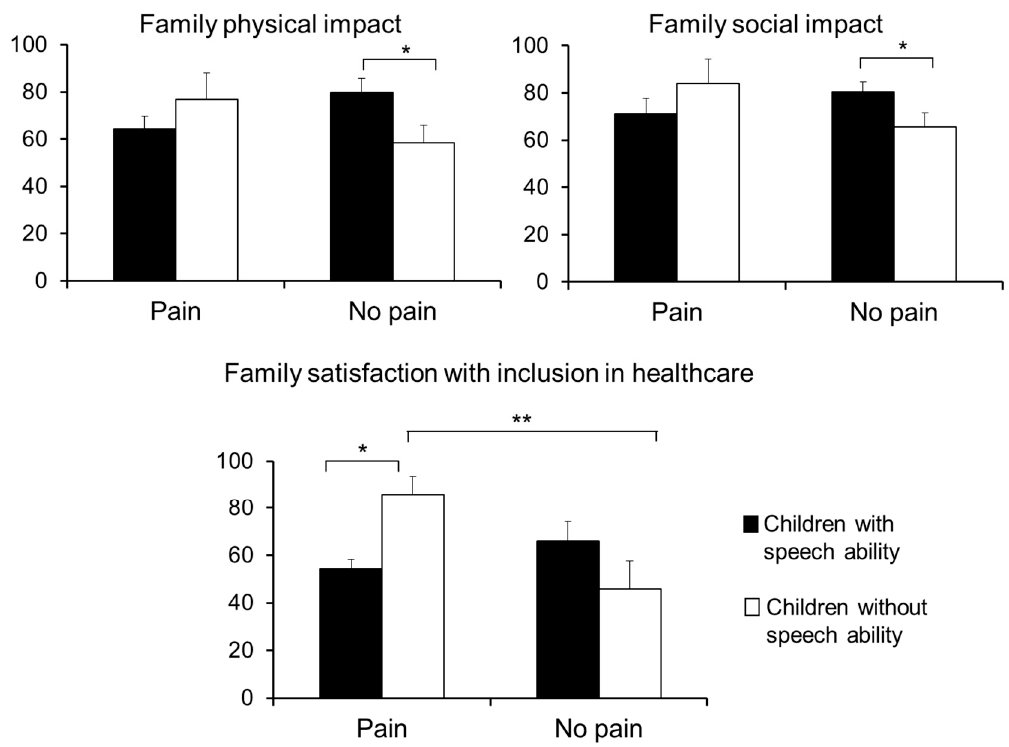
Figure 1. Mean and standard errors of the four groups of children in the significant dimensions of the Family Impact and Healthcare Satisfaction modules. * p < 0.05, ** p < 0.01.